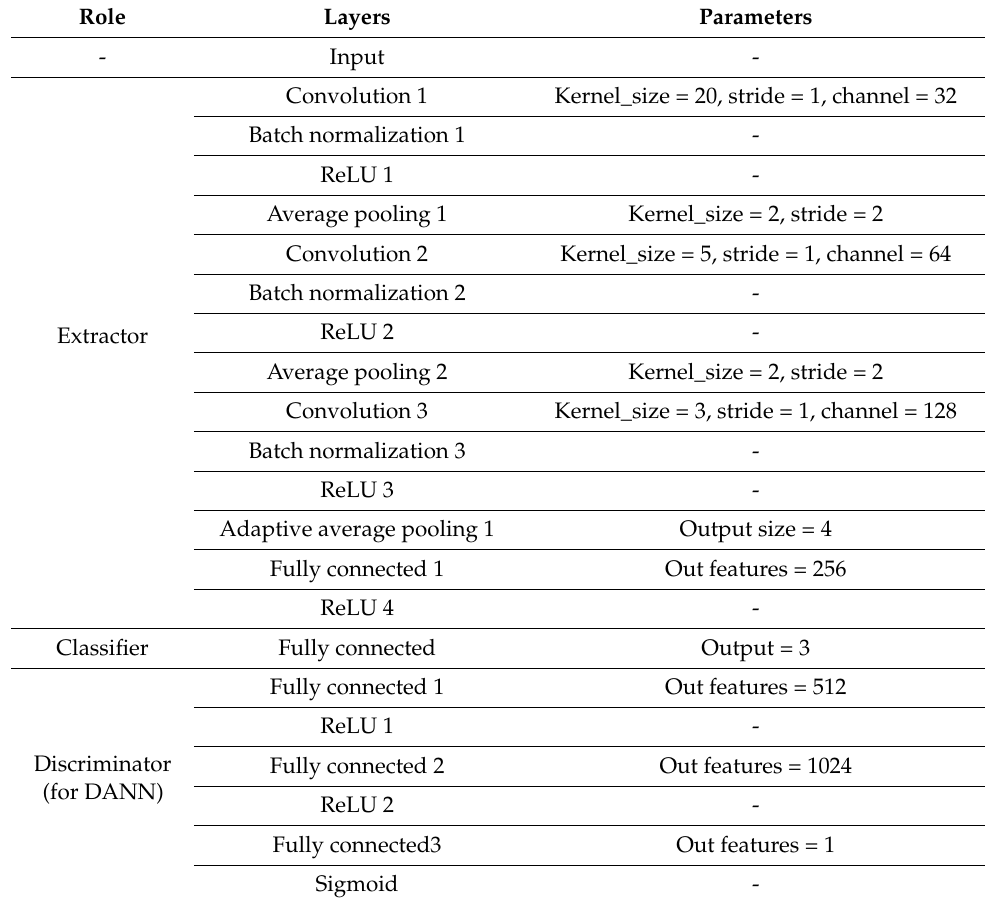
Table 3. Description of basic CNN structure and